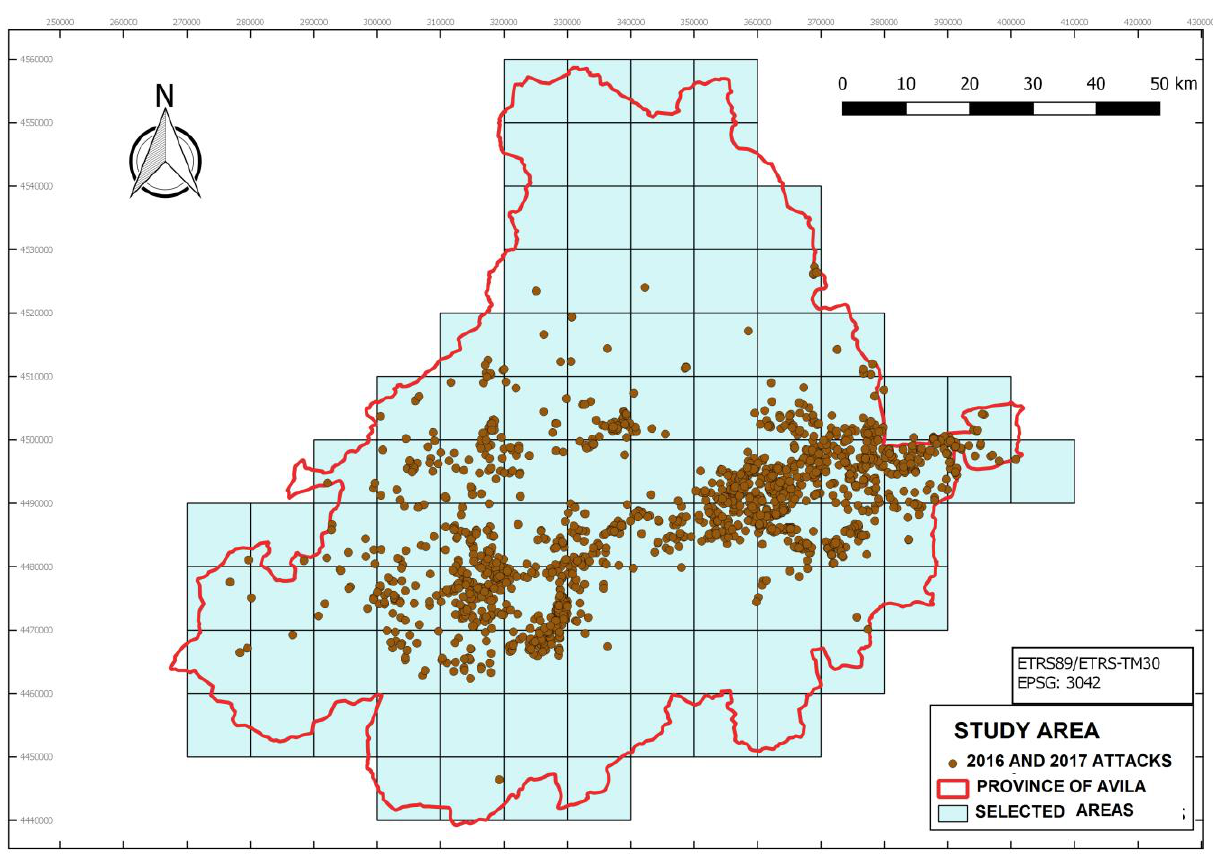
Figure 1. Selected study area.